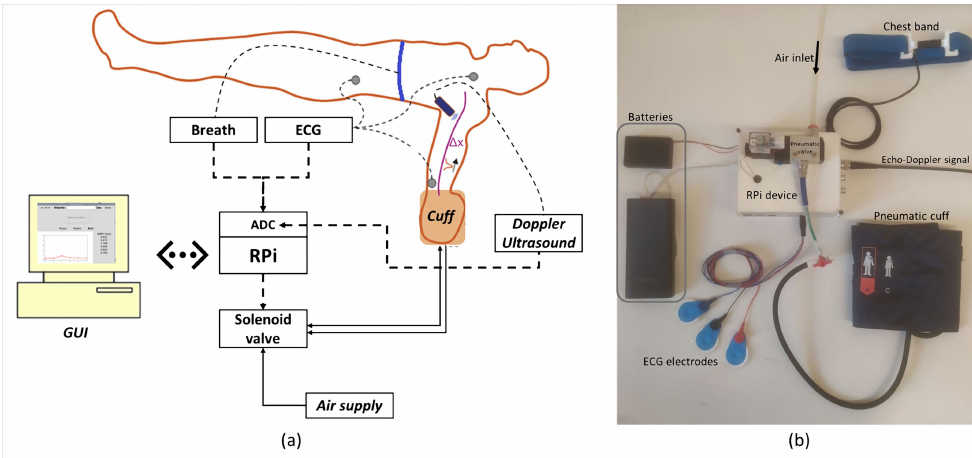
Figure 2. Device schematic and photographic representation. ( a ) Functional scheme. Electrical and pneumatic connections indicated by dashed and solid lines, respectively. Raspberry Pi (RPi) is the control unit wirelessly connected to a graphical computer interface on a PC. ( b ) Picture of the prototype enclosed in a 3D-printed box and connected to the external batteries, ECG electrodes, chest band, and Doppler signal (ultrasound machine not shown). Pneumatic valve was mounted on top of the device, and connected to compressed air supply (not shown) and